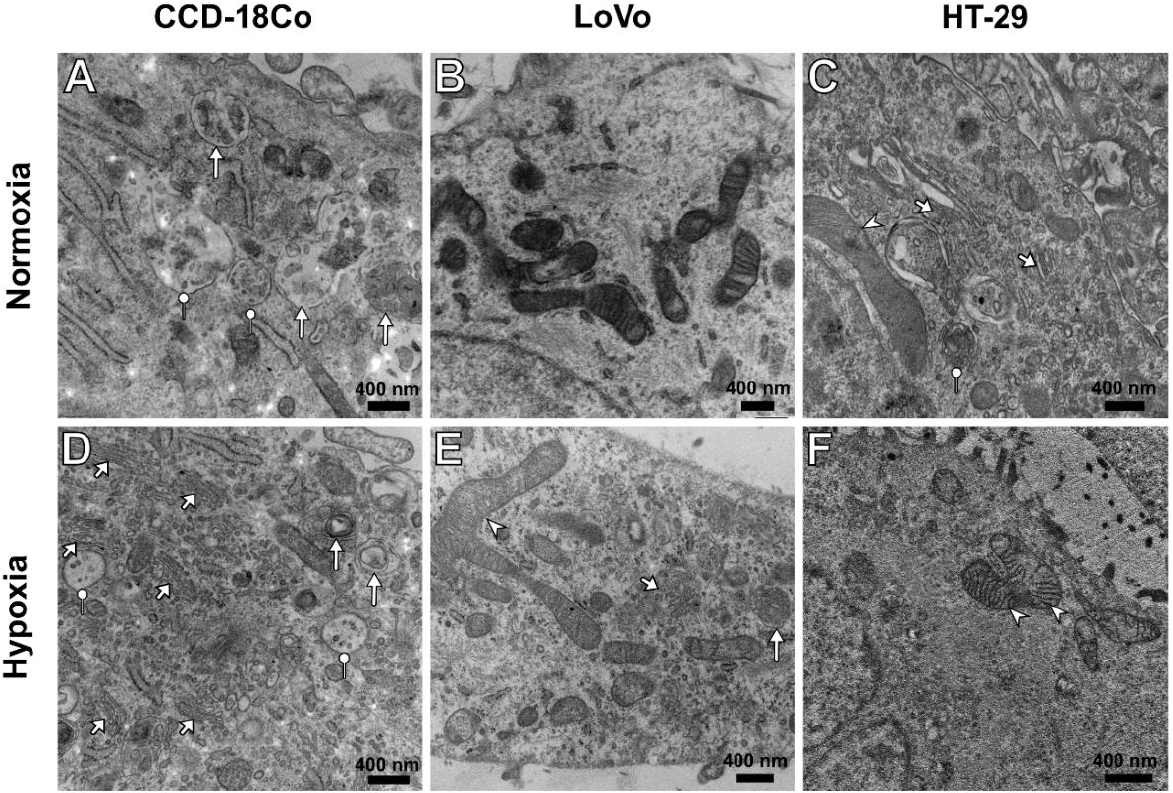
Figure 8. Micrographs of representative cells’ cytoplasm in normoxia ( A – C ) and hypoxia ( D – F ). ( A , D ) CCD-18Co cells in lower oxygenation tend to have more autophagic vacuoles (arrows) and multivesicular bodies (MVBs; dot marker), as well as more numerous Golgi apparatuses (short arrows). ( B , E ) Mitochondria in the LoVo cell line tend to be larger and fused (arrowhead), suggesting the dominance of fusion over the fission process. MVBs and autophagic vacuoles are less numerous than those in the CCD-18Co cell line. ( C , F ) Hypoxic mitochondria in HT-29 tend to be less electron-dense than the normoxic ones. No significant differences in autophagy or exocytosis were observed (n = 3 cells/each cell line).